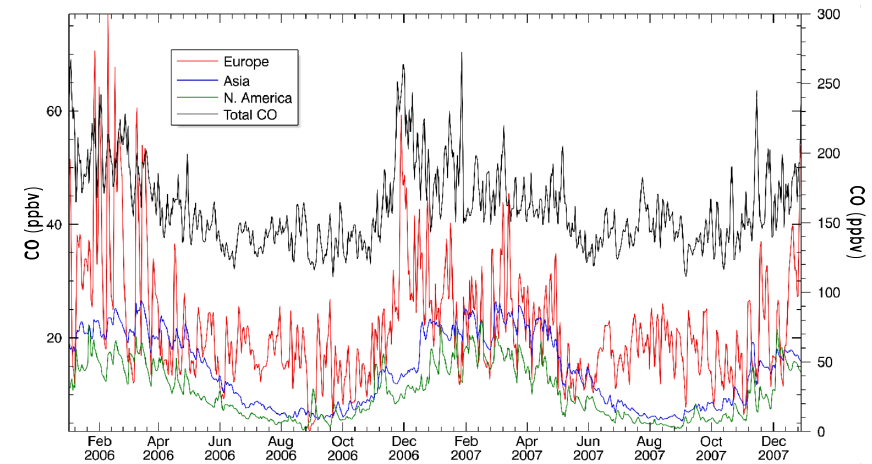
Figure 21. Monthly time series of the European (red), Asian (blue), and North American (green) anthropogenic contribution to the total surface CO (black) at Sde Boker as simulated by MOZART over 2006–2007. Distinct continents are scaled on the left vertical axis and total CO on the right vertical axis (adapted from Drori et al., 2012).